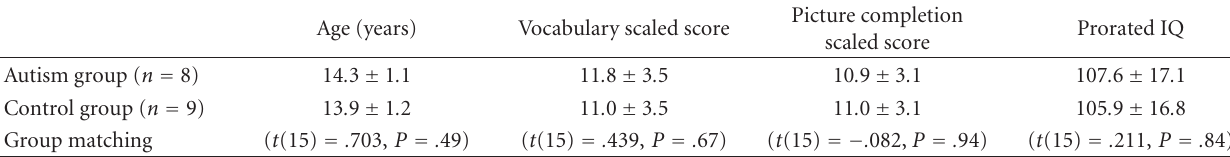
Table 1: Matching data for the autism and control groups. Values are mean values ±